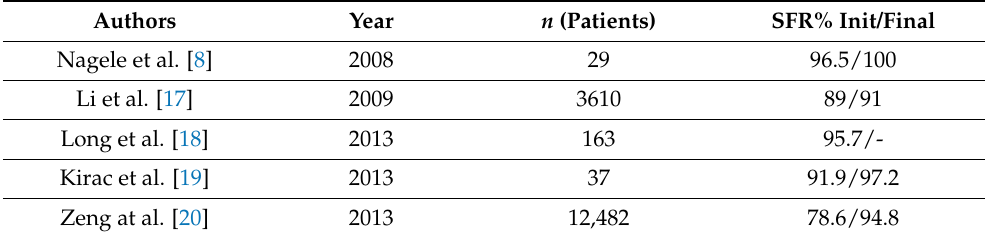
Table 3. Stone-free rate in